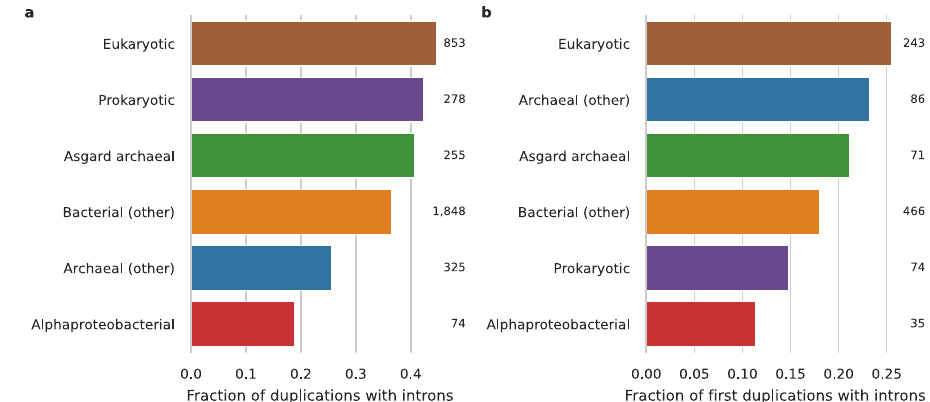
Fig. 4 Reconstruction of pre-duplication introns in Pfam duplications of different phylogenetic origins. a Fraction of duplications with introns traced to their pre-duplication state for different phylogenetic origins. Sixty percent of pairwise comparisons were signi fi cant, including all but one comparison with alphaproteobacterial duplications (Supplementary Table 6). b Fraction of the most ancestral duplication in an acquisition or invention with introns traced to their pre-duplication state. Differences between groups were not signi fi cant. Numbers indicate the number of